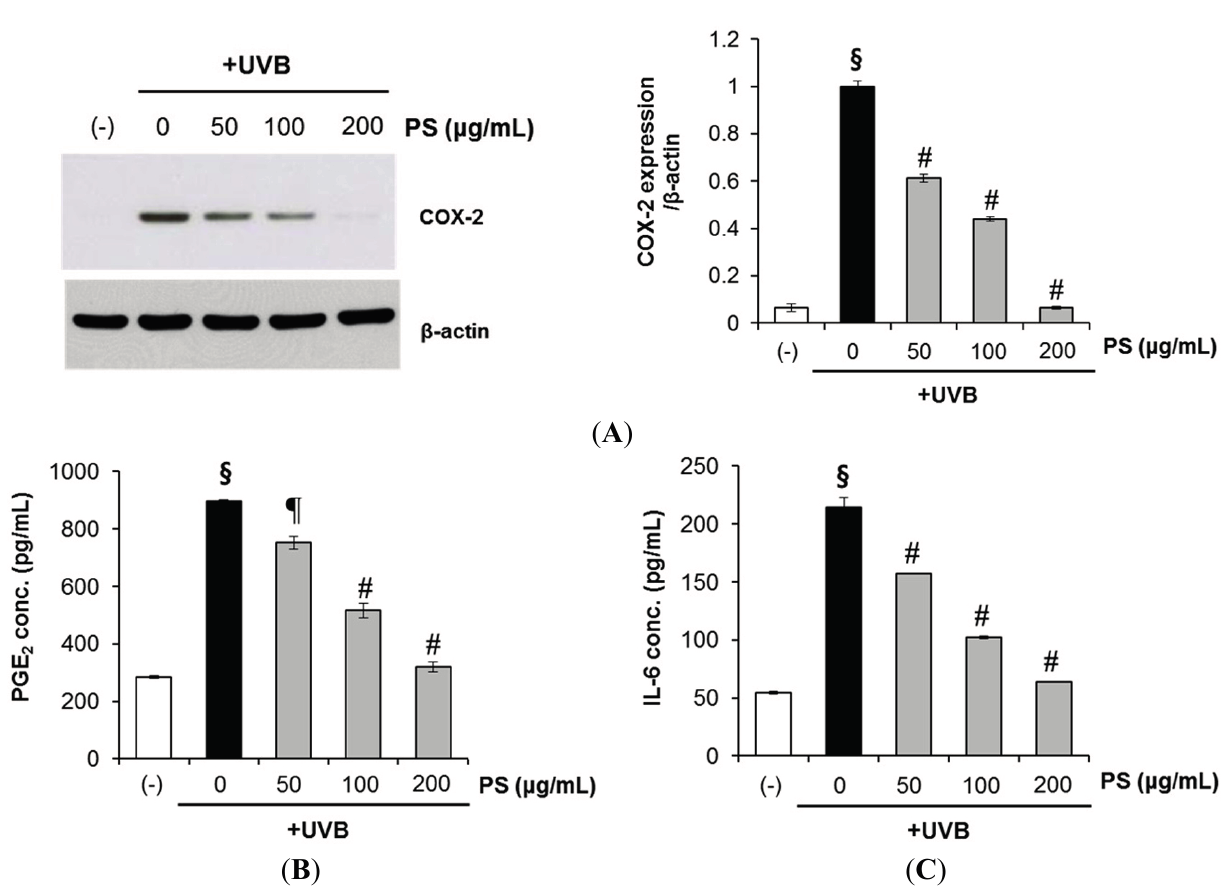
Figure 7. Phloretin 3',3-disulfonate suppresses UVB-mediated inflammation cytokine production in human HaCaT keratinocytes. HaCaT cells were treated with the test substances (50–200 μ g/mL phloretin 3',3-disulfonate) after irradiation with 20 mJ/cm 2 UVB. ( A ) After 12 h, cyclooxygenase (COX)-2 protein expression was assessed by Western blotting. The histogram depicting relative COX-2 protein expression levels was normalized to β -actin expression level; ( B ) Prostaglandin-E 2 (PGE 2 ) and ( C ) interleukin-6 (IL-6) concentrations in cell culture supernatants from the same experiments. Data are mean ± standard deviation of five independent experiments. § p < 0.01 compared with the vehicle-treated group, ¶ p < 0.05 compared with the UVB-treated group, # p < 0.01 compared with the UVB treated group. ( N = 3); PS: Phloretin